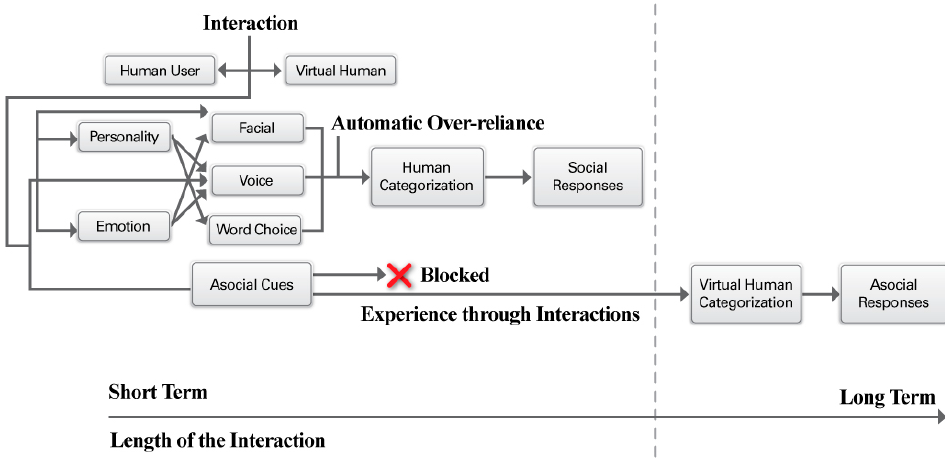
Figure 1. The framework of how humans respond socially to virtual humans.